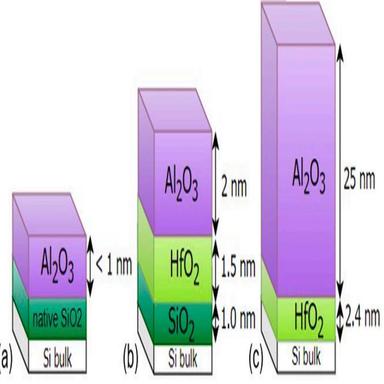
The schematic representation of the structure of (a) the sub-nanometer ultrathin class of samples (with or without native oxide); (b) trilayer of thin metal oxide layers and (c) bilayers with deeply buried layer of HfO2 or Al2O3 and overlayer of approximately 10, 15, and 25 nm composed of the opposing metal-oxide.